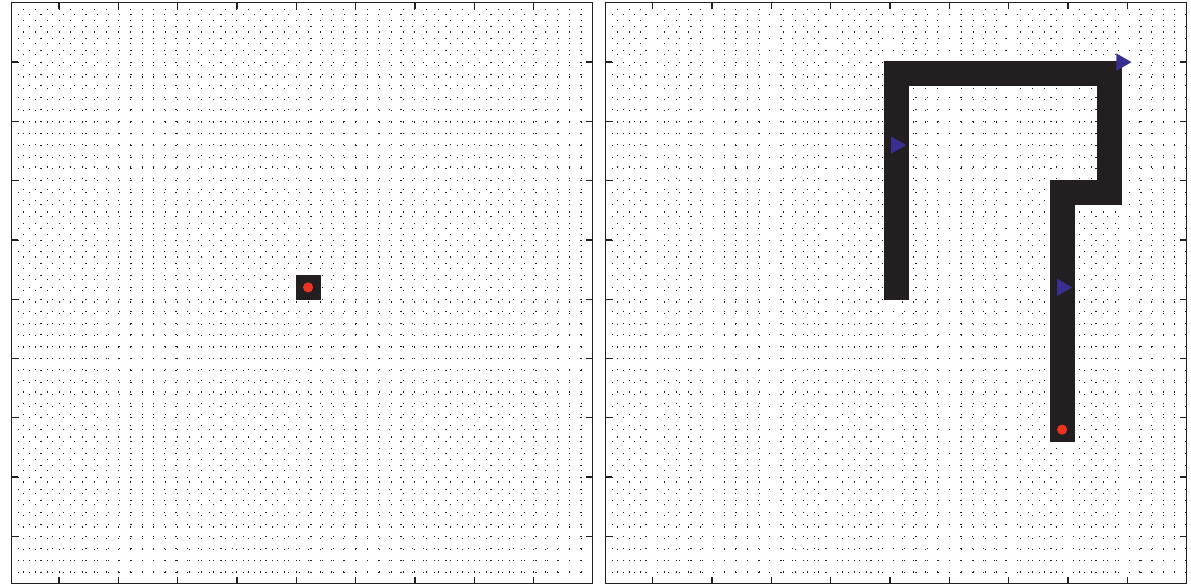
Figure 4: Portraying the exploration of the hunter: (a) the initial position of the agent and (b) trail of the hunter after some time as it explores the